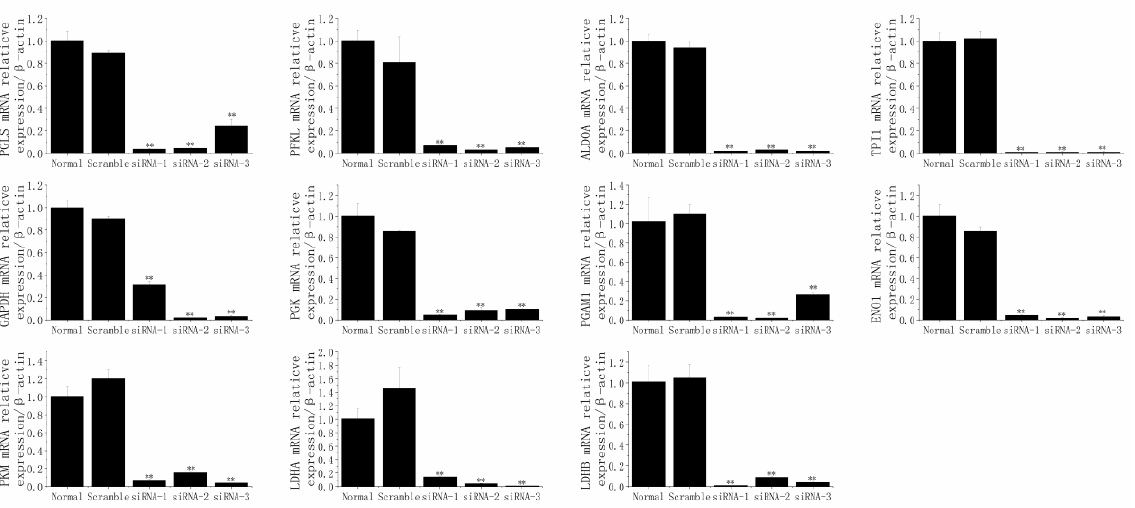
Figure 8. The mRNA relative expression levels of 6-phosphogluconolactonase (PGLS), phosphofructokinase, liver type (PFKL), aldolase, fructose-bisphosphate A (ALDOA), triosephosphate isomerase 1 (TPI1), glyceraldehyde-3-phosphate dehydrogenase (GAPDH), phosphoglycerate kinase 1 (PGK1), phosphoglycerate mutase 1 (PGAM1), enolase 1 (ENO1), pyruvate kinase M1/2 (PKM), lactate dehydrogenase A (LDHA), and lactate dehydrogenase B (LDHB) were successfully and individually reduced by their specific siRNA sequences in MAC-T cells. ** p < 0.01.